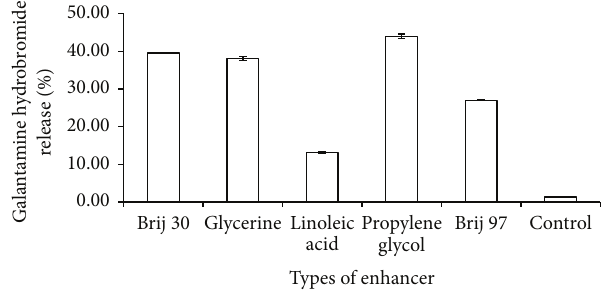
Figure 4: Drug release profile of gel drug reservoirs with different types of enhancer (mean ± S.D.; 𝑛 = 3